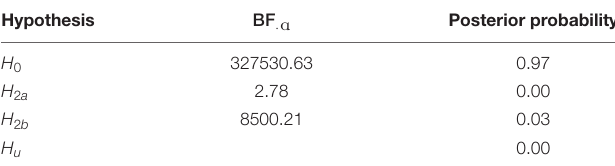
TABLE 4 | Bayesian informative hypothesis testing (ANOVA) of practical relevance.